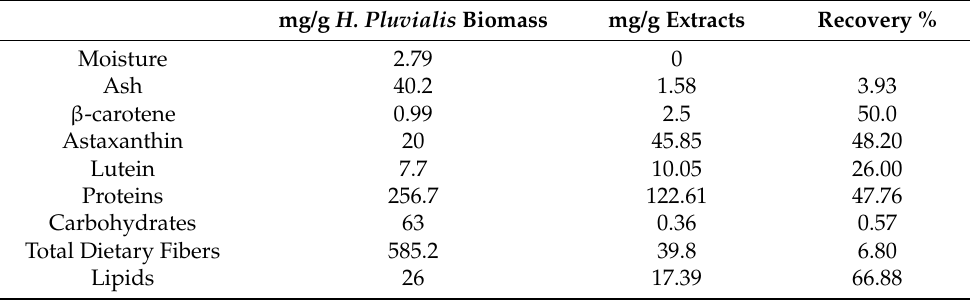
Table 1. H. pluvialis biomass and extracts composition.